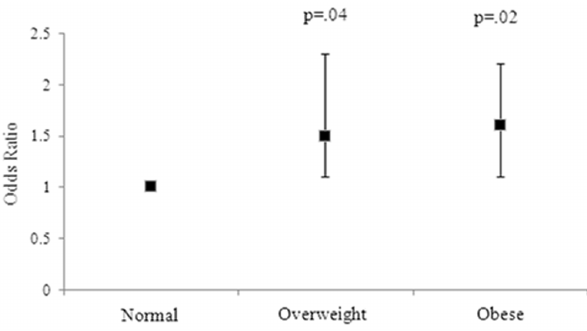
Figure 1. Adjusted odds ratios for women with EDS for BMI groups. Error bars represent the 95% CI. Group 1 (ideal BMI) is the reference group, with a broken line indicating the threshold of significance.